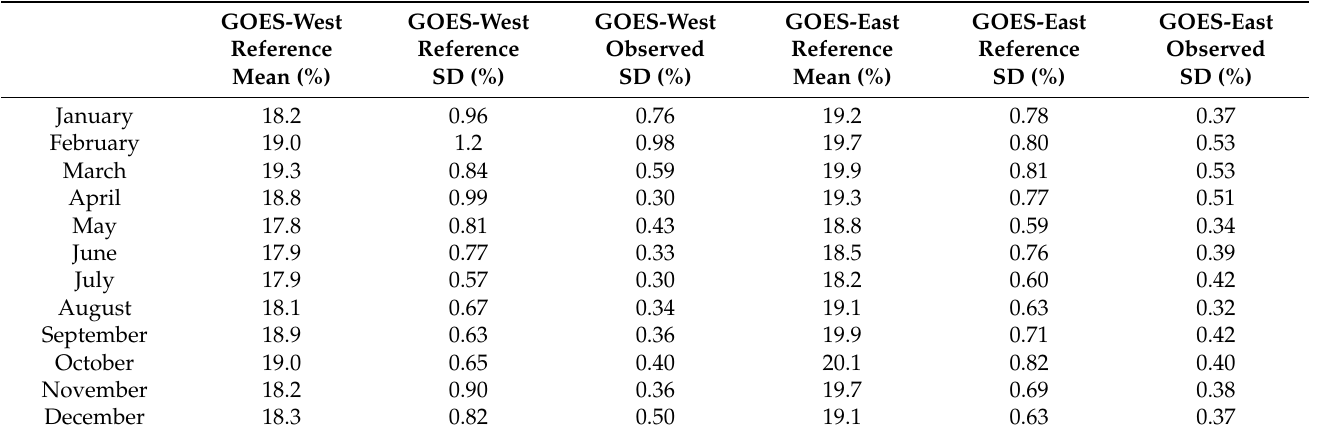
Table 2. Monthly means and standard deviations (SD) of the full-disk scaled radiances for GOES-West and GOES-East used as the reference values and computed from GOES-R. The observed standard deviations computed from the GOES-IP series that are used in the fitting process are also